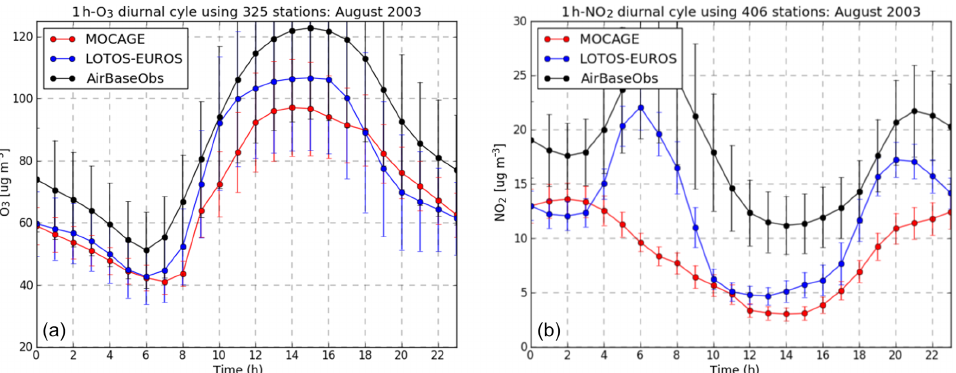
Figure 8. Diurnal cycle for ozone (a) and NO 2 (b) concentrations from NR (blue, MOCAGE), CR (red, LOTOS-EUROS) and AirBase background observations (black dots) for the period of August 2003. The vertical bars represent the standard deviation over the dataset (different days and